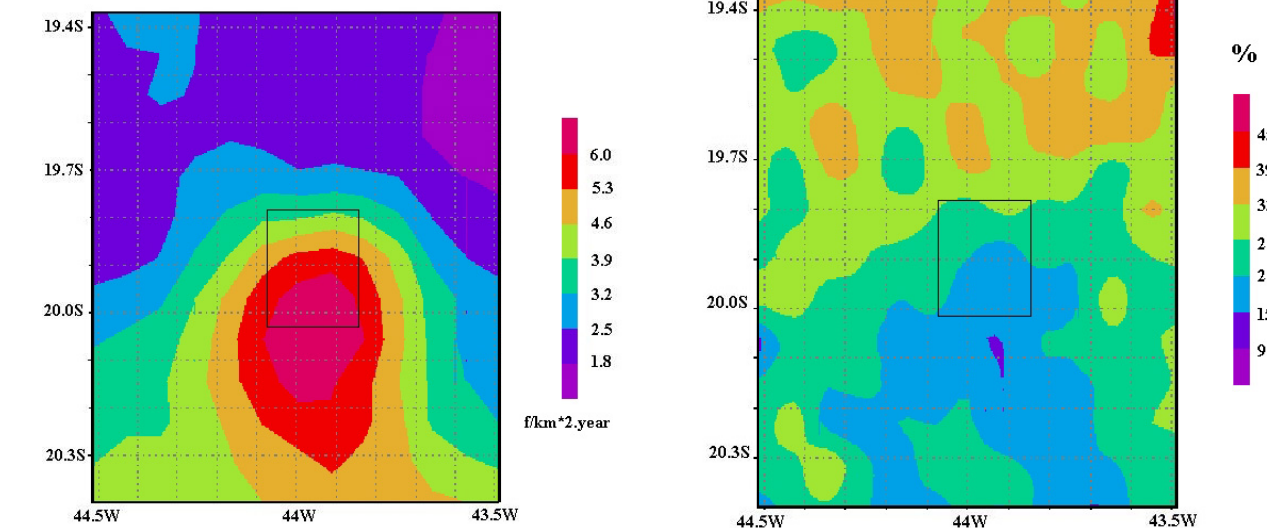
Fig. 2. Eight-year (1989–1996) mean annual negative flash density in flashes km − 2 yr − 1 centered on Belo Horizonte (indicated by a black rectangle), at a spatial resolution of 9km.